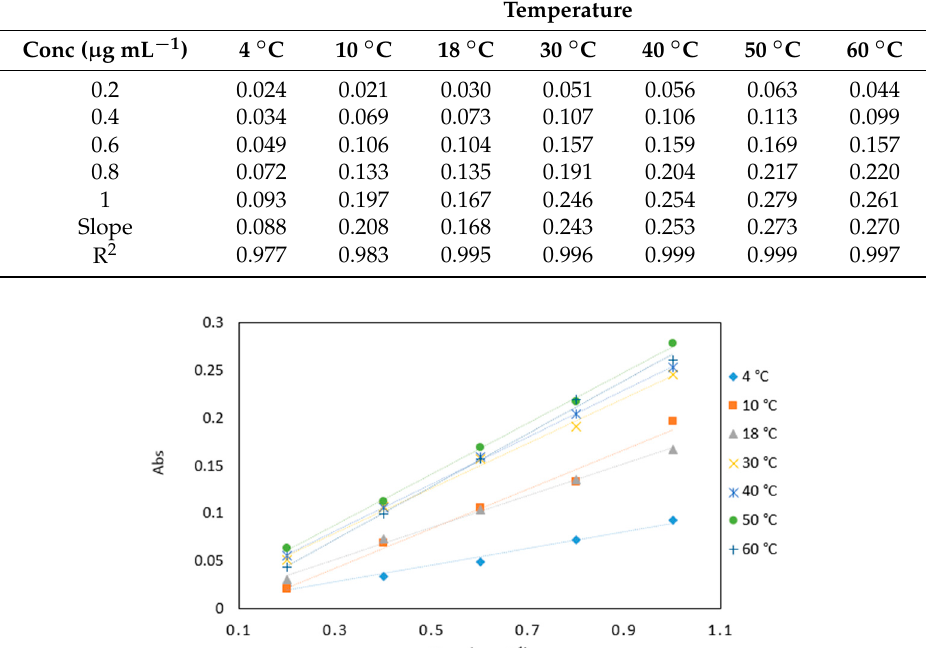
Table 3. Average absorbance values of arsenic samples (0.2–1 µ g mL − 1 ) analyzed at various incubation temperatures (4, 10, 18, 30, 40, 50 and 60 ◦ C). All measurements were carried out in triplicate ( n = 105).